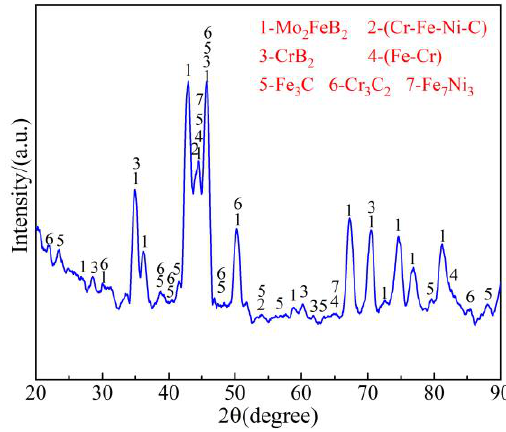
Figure 11. XRD of the Mo 2 FeB 2 coating.